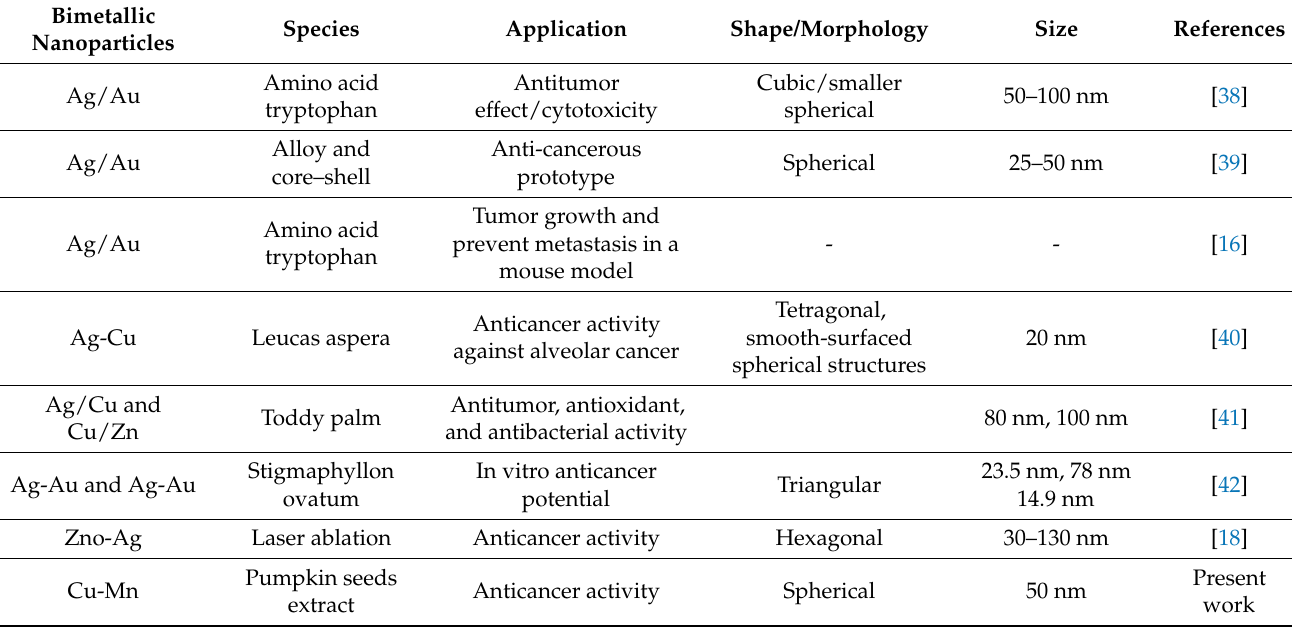
Table 2. Comparison of earlier reported bimetallic NPs and current biosynthesized bimetallic NPs.